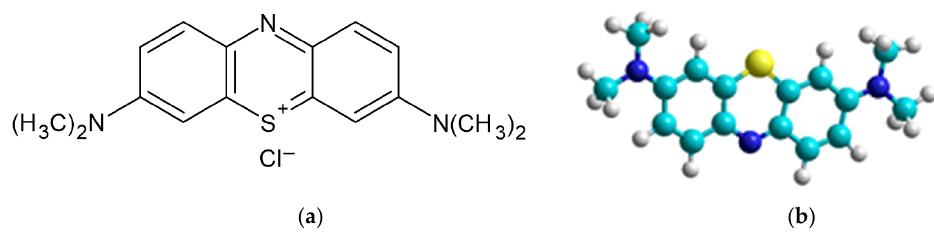
( a ) ( b ) Chemical ( a ) and molecular ( b ) structure of cationic dye, methylene blue. Figure 2. Chemical ( a ) and molecular ( b ) structure of cationic dye, methylene Figure 2.